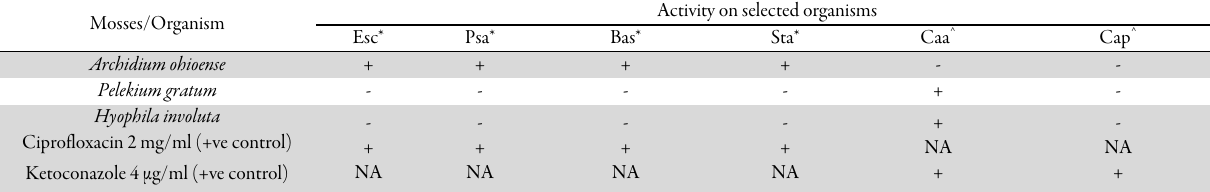
Table 5. Screening of antimicrobial activity of the Raffia palm wine extracts of Archidium ohioense, Pelekium gratum, Hyophila involuta against different microorganisms Mosses/Organism